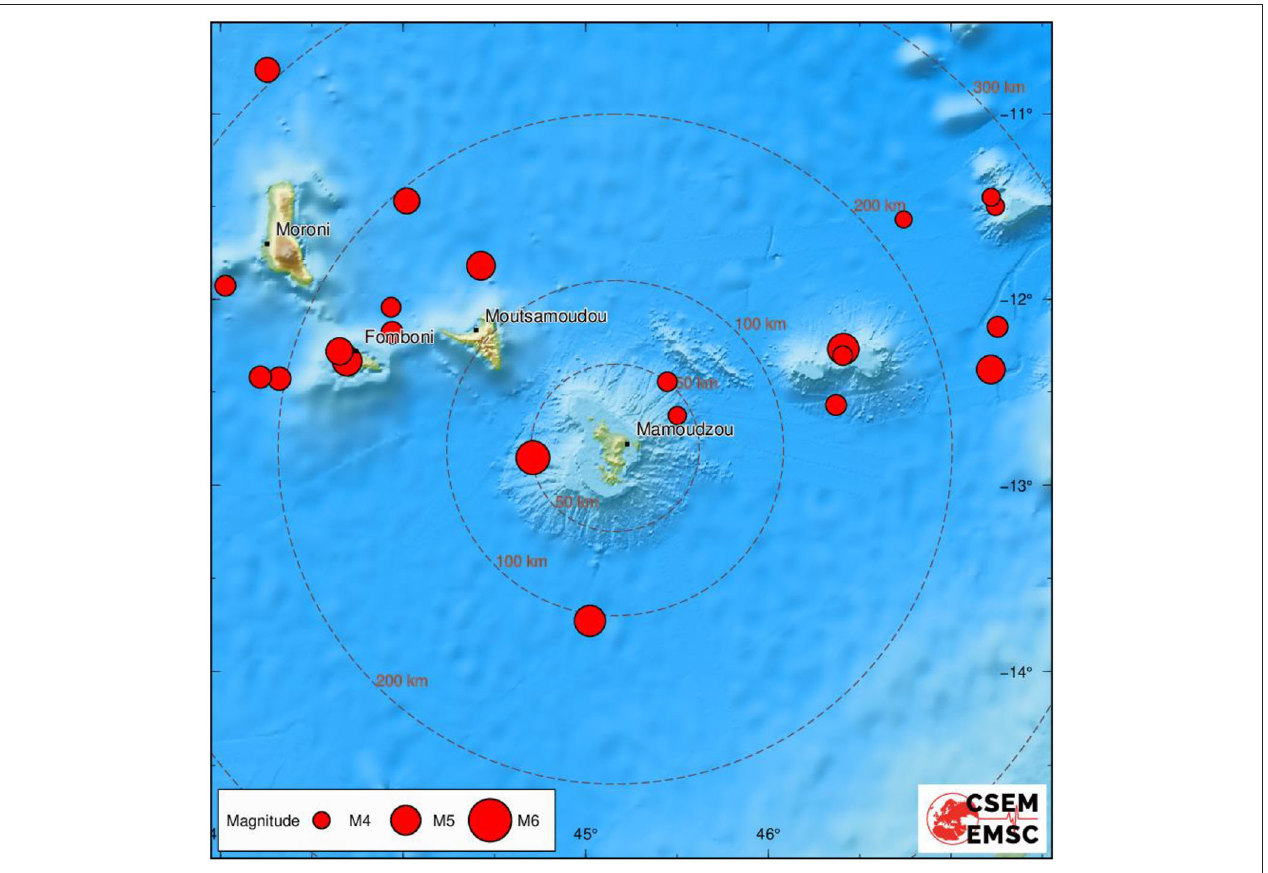
FIGURE 2 | Historic seismicity map near the Mayotte island using the ISC catalog for M > = 4 earthquakes (1964–2010). Largest event reaches magnitude